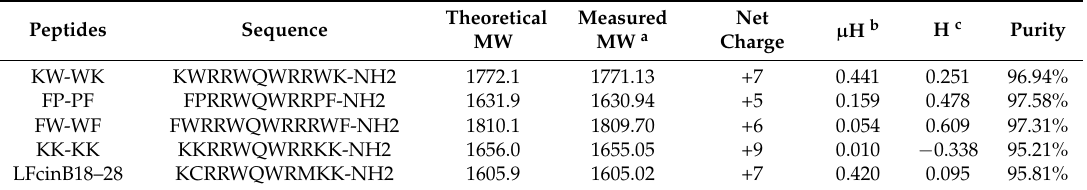
Table 1. Peptide design and key physicochemical parameters.